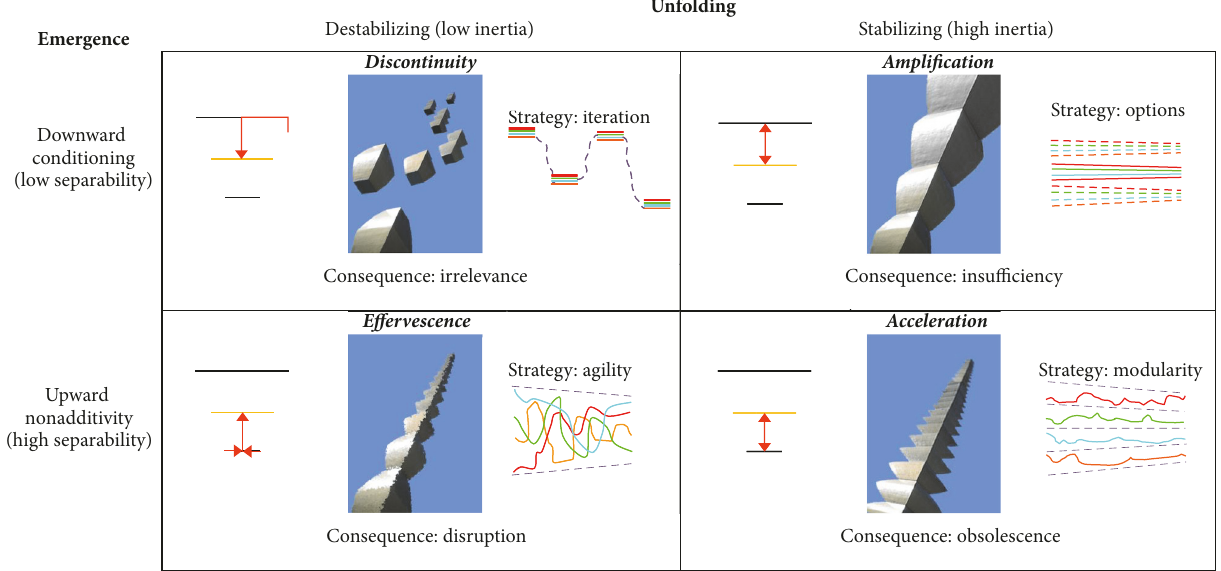
Figure 3: Types of dynamic complexity, as a function of prevailing mechanisms, and strategies for dealing with them. Note . The three horizontal lines on the left side of each cell in the table represent, respectively, from top to bottom, the macro level, the meso-level (uses orange color to highlight the fact that it represents the context deemed relevant by project participants: task environment, etc.), and the micro level. The red arrows suggest the direction of interlevel influences. The pictures in the middle part of each cell rely on alterations of the Endless Column(orColumnoftheInfinite)byConstantinBrˆancus¸i(completedin1938,TˆarguJiu,Romania)torepresentthefourpatternsofdynamic complexity. Strategies on the right side of each cell suggest ways of organizing project activities, namely, of connecting them simultaneously as well as intertemporally, which are likely to be most effective for dealing with each type of dynamic complexity. Colored lines represent strands of activities and the extent to which these change direction in